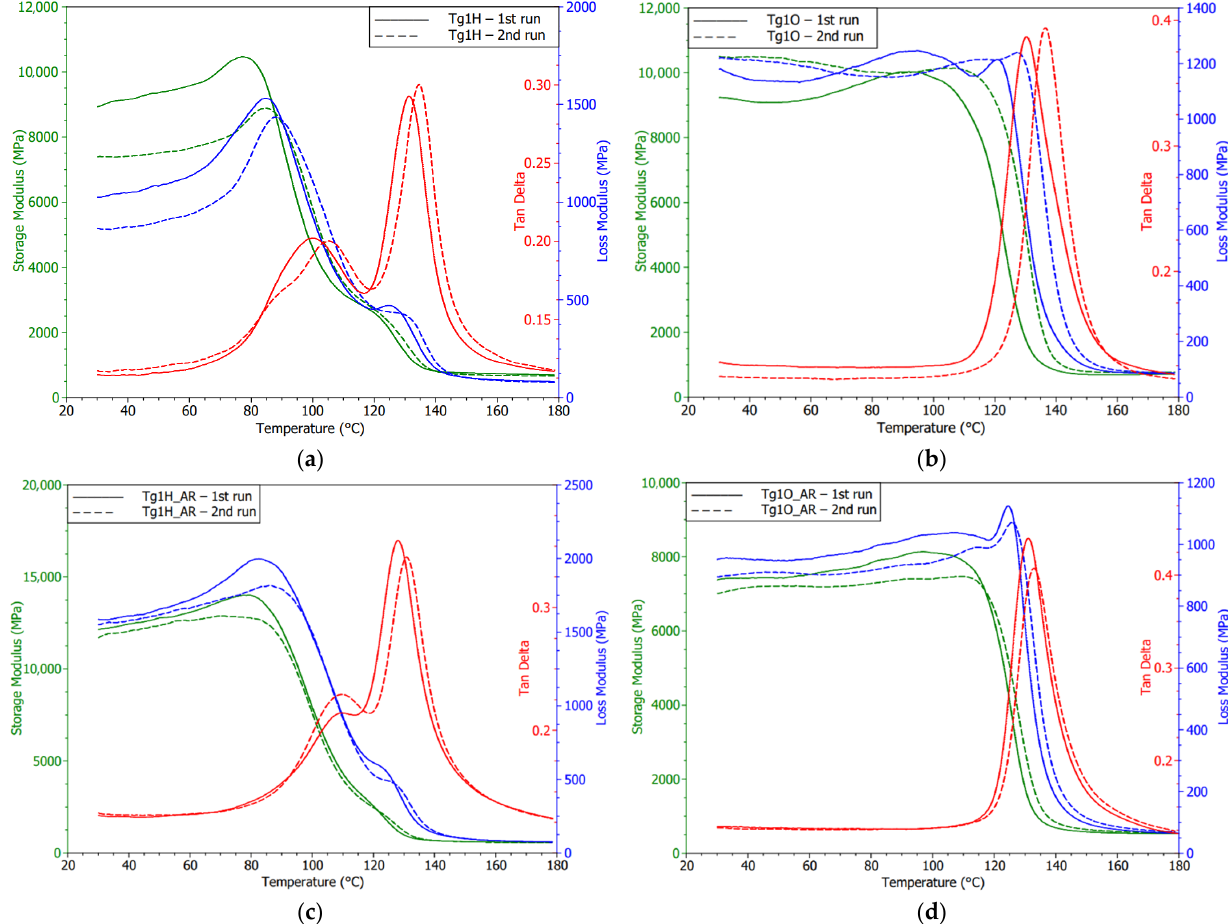
Figure 13. DMA diagrams of the Tg1 substrates and with surface finish: ( a ) HASL; ( b ) OSP; ( c ) HASL_AR; ( d ) OSP_AR.